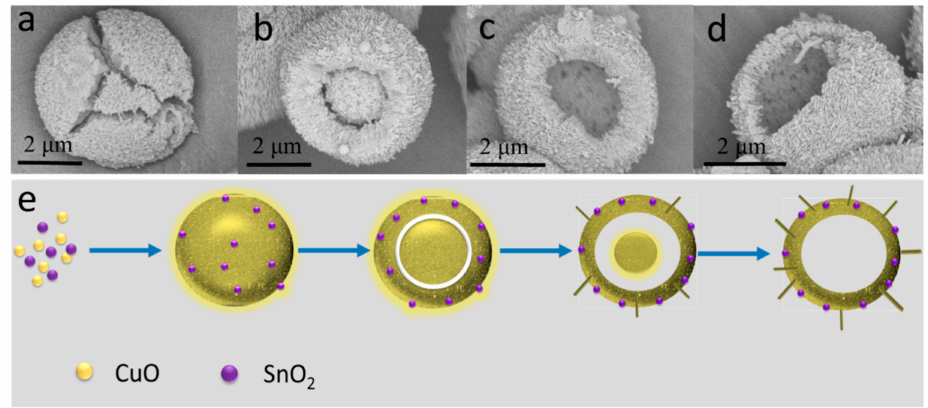
Figure 6. FESEM images of products obtained after different hydrothermal reaction time of ( a ) 1 h; ( b ) 4 h; ( c ) 8 h; and ( d ) 12 h; ( e ) Schematic illustration of the formation of the hollow